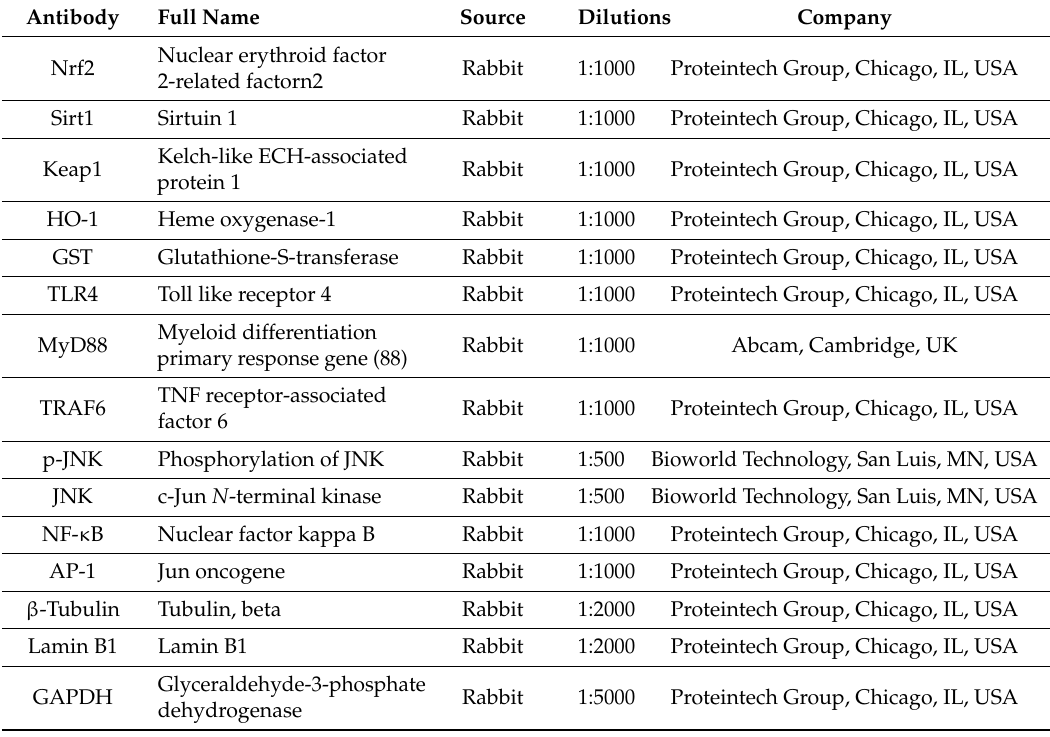
Table 2. The information of the antibodies used in the present